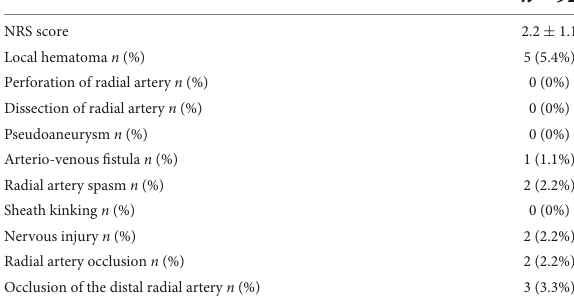
TABLE 5 Pain score and